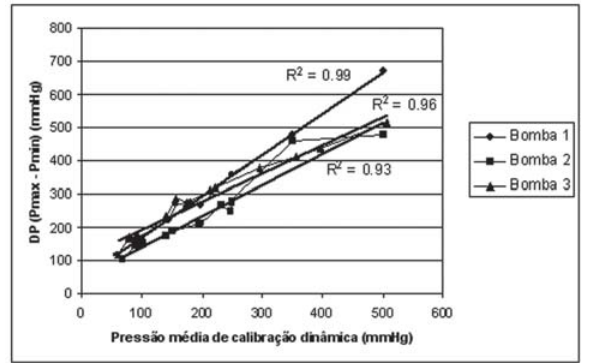
Fig. 6 – Relação entre a pressão média de calibração dinâmica e a diferença de pressão (Pmax – Pmin). Bombas 1, 2 e 3